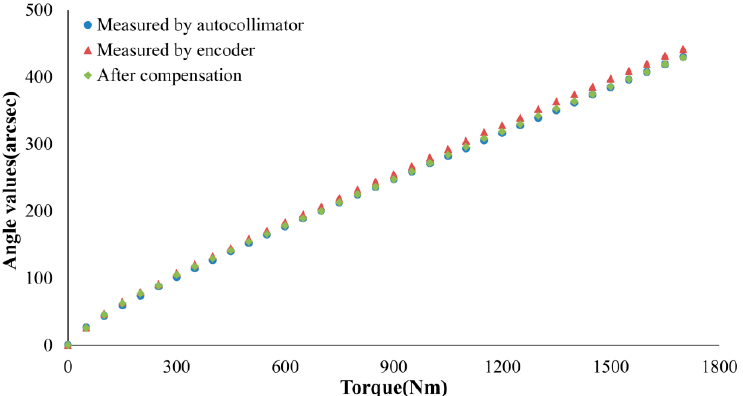
Figure 6. Verification experiment using an ultra-autocollimator.